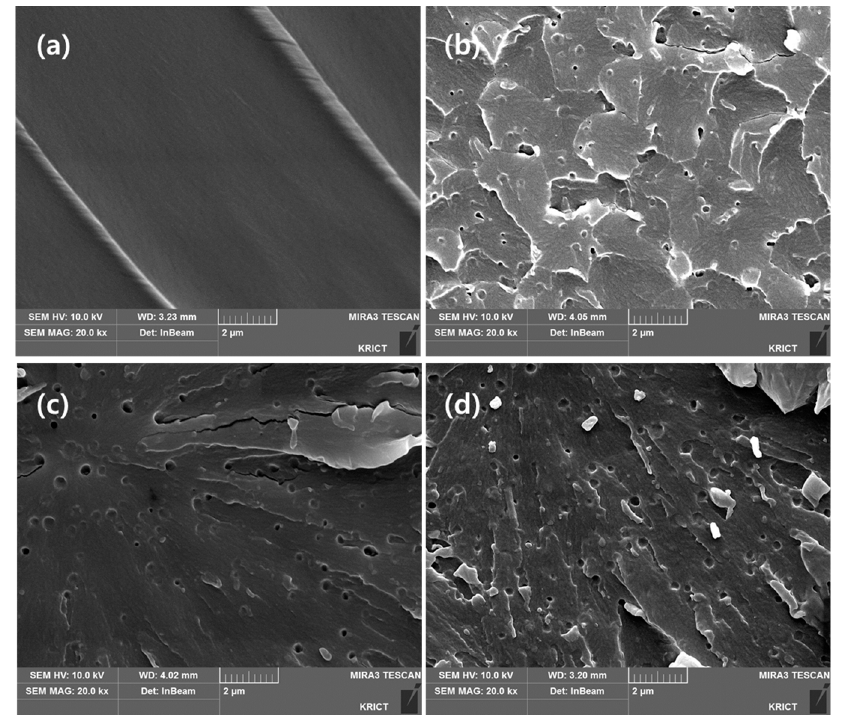
Figure 8. FE-SEM images of the fractured surfaces: ( a ) binder, ( b ) PU-5, ( c ) PU-10, and ( d ) PU-15.